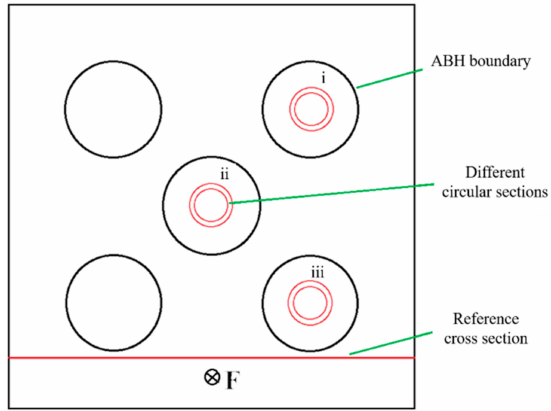
Figure 6. Top view of the plate with embedded two-dimensional ABH